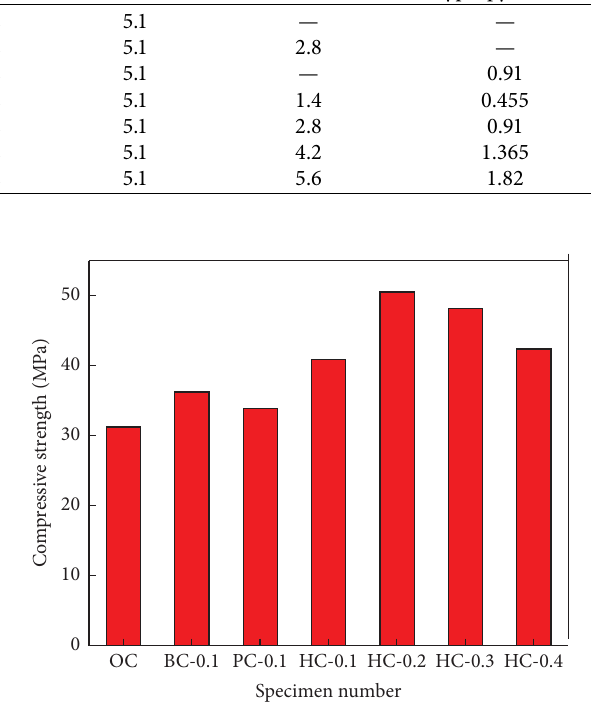
Figure 1: Compressive